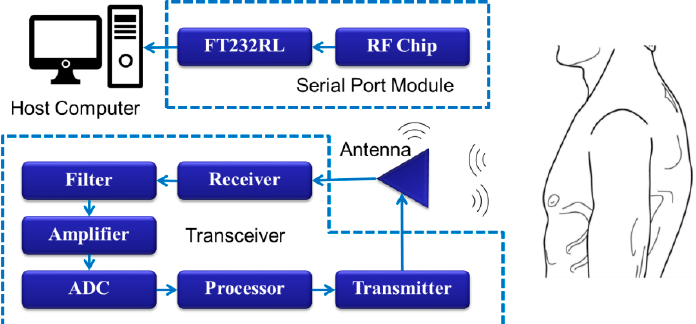
Figure 3. Schematic diagram of hardware system.